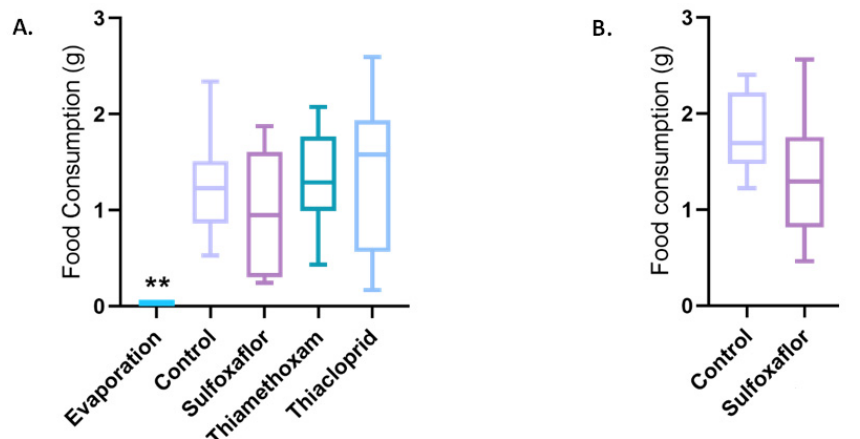
Figure 2. Food consumption across treatments. ( A ) Total 5-day food consumption of bees in the lower concentration trials compared to evaporation feeders. One-way ANOVA with Tukey correc- tion for multiple comparisons, p values: evaporation vs. control (0.0049 **), evaporation vs. thiaclo- prid (0.0035 **), evaporation vs. sulfoxa fl or (0.0275) and evaporation vs. thiamethoxam (0.0034 **). ( B ) Total 5-day food consumption of bees in the higher concentration trials.